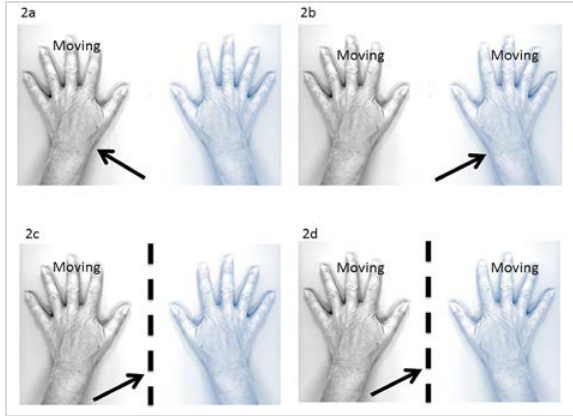
Figure 2: The mirror paradigm used in the study. The paretic/nondominant is illustrated in blue. The arrow illustrates the gaze direction. The dotted line represents the mirror. The movement task consisted in a paced hand opening and closing. Participants either moved the unaffected/dominant hand (uniman- ual task, figs 2c and 2a) or both hands simultaneously (bimanual task, figs 2b and 2d). With the mirror, the mirror reflection of the unaffected/dominant hand was observed (figs 2a and 2b). Without the mirror, the unaffected/dominant hand (unimanual task, fig. 2a) or the affected/nondominant hand (bimanual task, fig. 2b) were